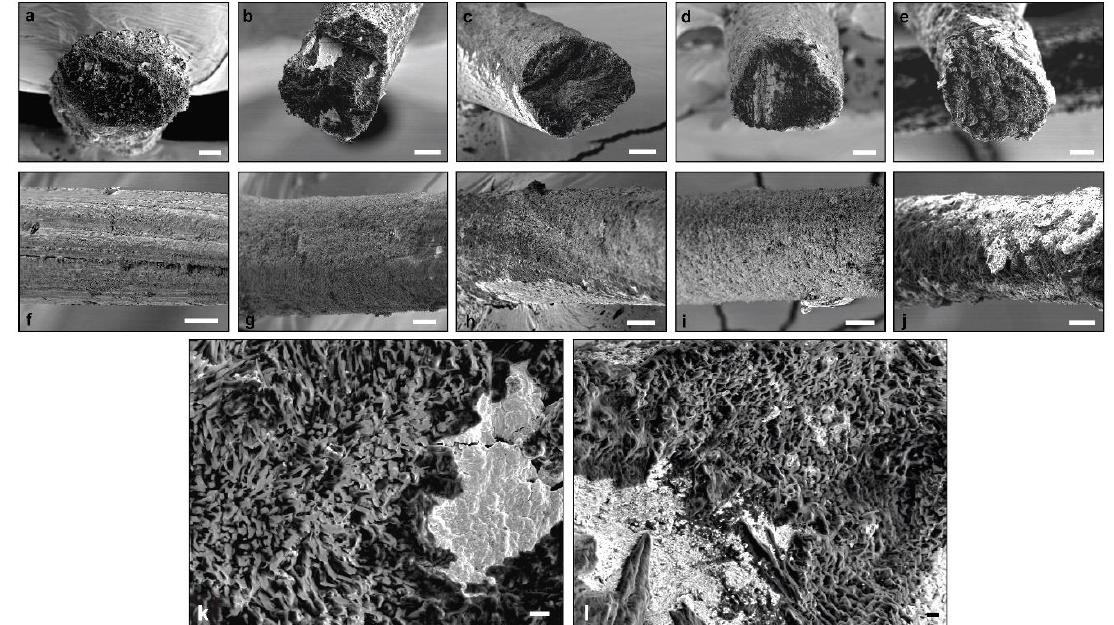
Figure 5. (Top) SEM micrographs of the lateral and fracture cross-section surface of the spun CHI/CNF composite fibers of: ( a , f ) CHI4; ( b , g ) CHI4/CNF0.2; ( c , h ) CHI4/CNF0.3; ( d , i ) 4CHI/CNF0.4 and ( e , j ) CHI4/CNF0.5. Scale bars: 20 μ m. (Bottom) SEM micrographs at higher magnification of fracture cross-section surface of the spun CHI/CNF composite fibers of: ( k ) CHI4 and ( l ) CHI4/CNF0.4. Scale bars: 2 μ m.